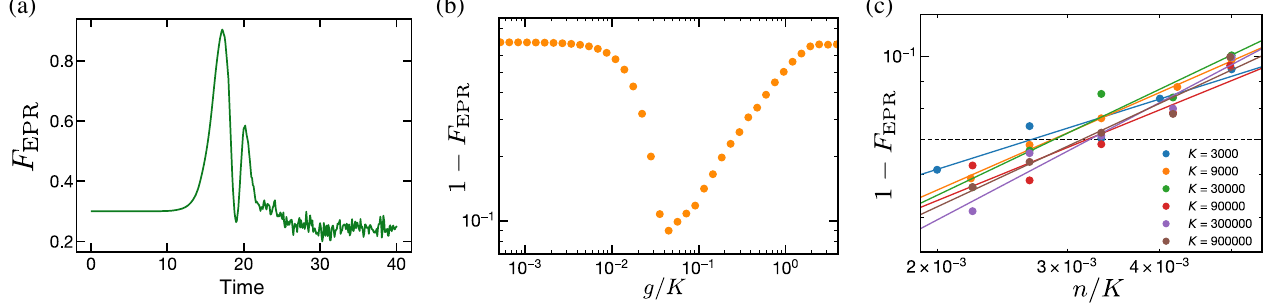
FIG. 12. Procedure for determining the channel capacity in 0D RUCs. (a),(b) For fixed n and K , we compute the per qubit fidelity while sweeping both the evolution time and coupling strength g . (a) The fidelity as a function of evolution time with coupling strength g S =N ¼ π . (b) After optimizing the evolution time, the fidelity as fixed is optimized at the first local maximum, which corresponds to η d a function of the coupling strength g is maximal when g (and, correspondingly, the average operator size S ) is tuned to balance errors due to size addition and the finite number of couplings (see Sec. VIII C for details). The data shown correspond to n ¼ 38 and K ¼ 9000 . (c) The channel capacity is defined as the maximum number of qubits that can be teleported while maintaining the fidelity per qubit 1 Þ ≤ 0 . 07 (dashed line). To determine this number, we fit the optimal fidelity as a function of n (for above a fixed threshold, i.e., 1 − F ð EPR each K ) with a linear fit in log space and compute the intercept of the fit with the threshold fidelity. The fits approximately collapse with respect to n=K , indicating that the channel capacity is linear in K